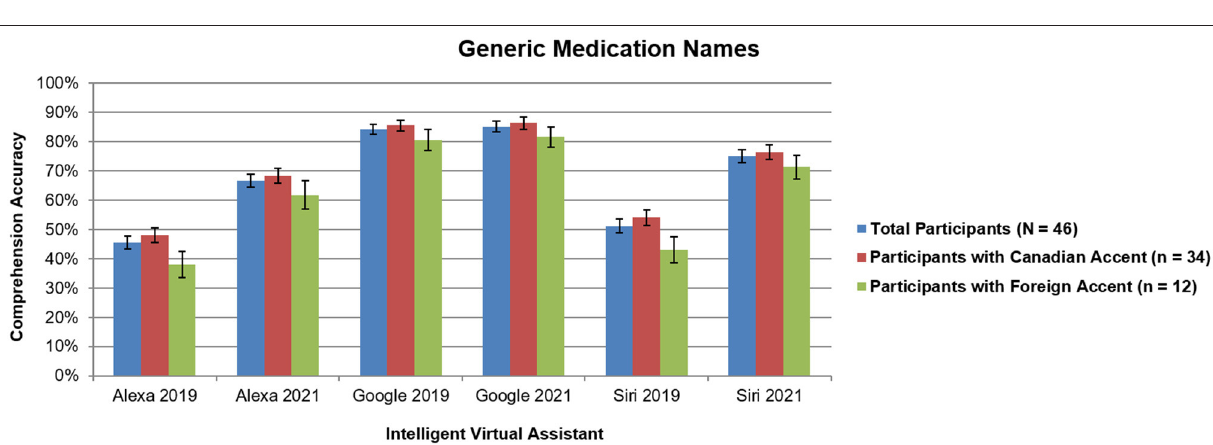
FIGURE 2 | Intelligent virtual assistant comprehension accuracy of generic names for the top 50 most dispensed medications in the United States across all participants ( N = 46) as a comparison between 2019 and 2021, shown with standard errors for each mean. Canadian accent participants ( n = 34); foreign accent participants ( n = 12). Percentages represent the average accuracy rates for participants across all 50 medication names. See text for more